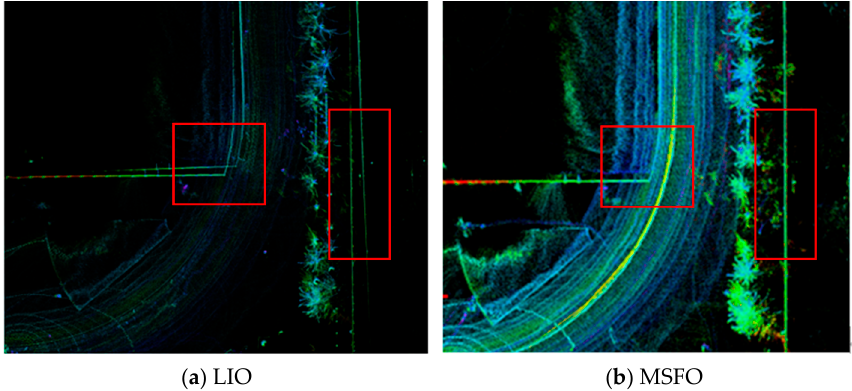
Figure 8. Point cloud details: error accumulation occurs when LIO returns to the origin and leads to point cloud stratification. Meanwhile, this situation does not occur in MSFO.